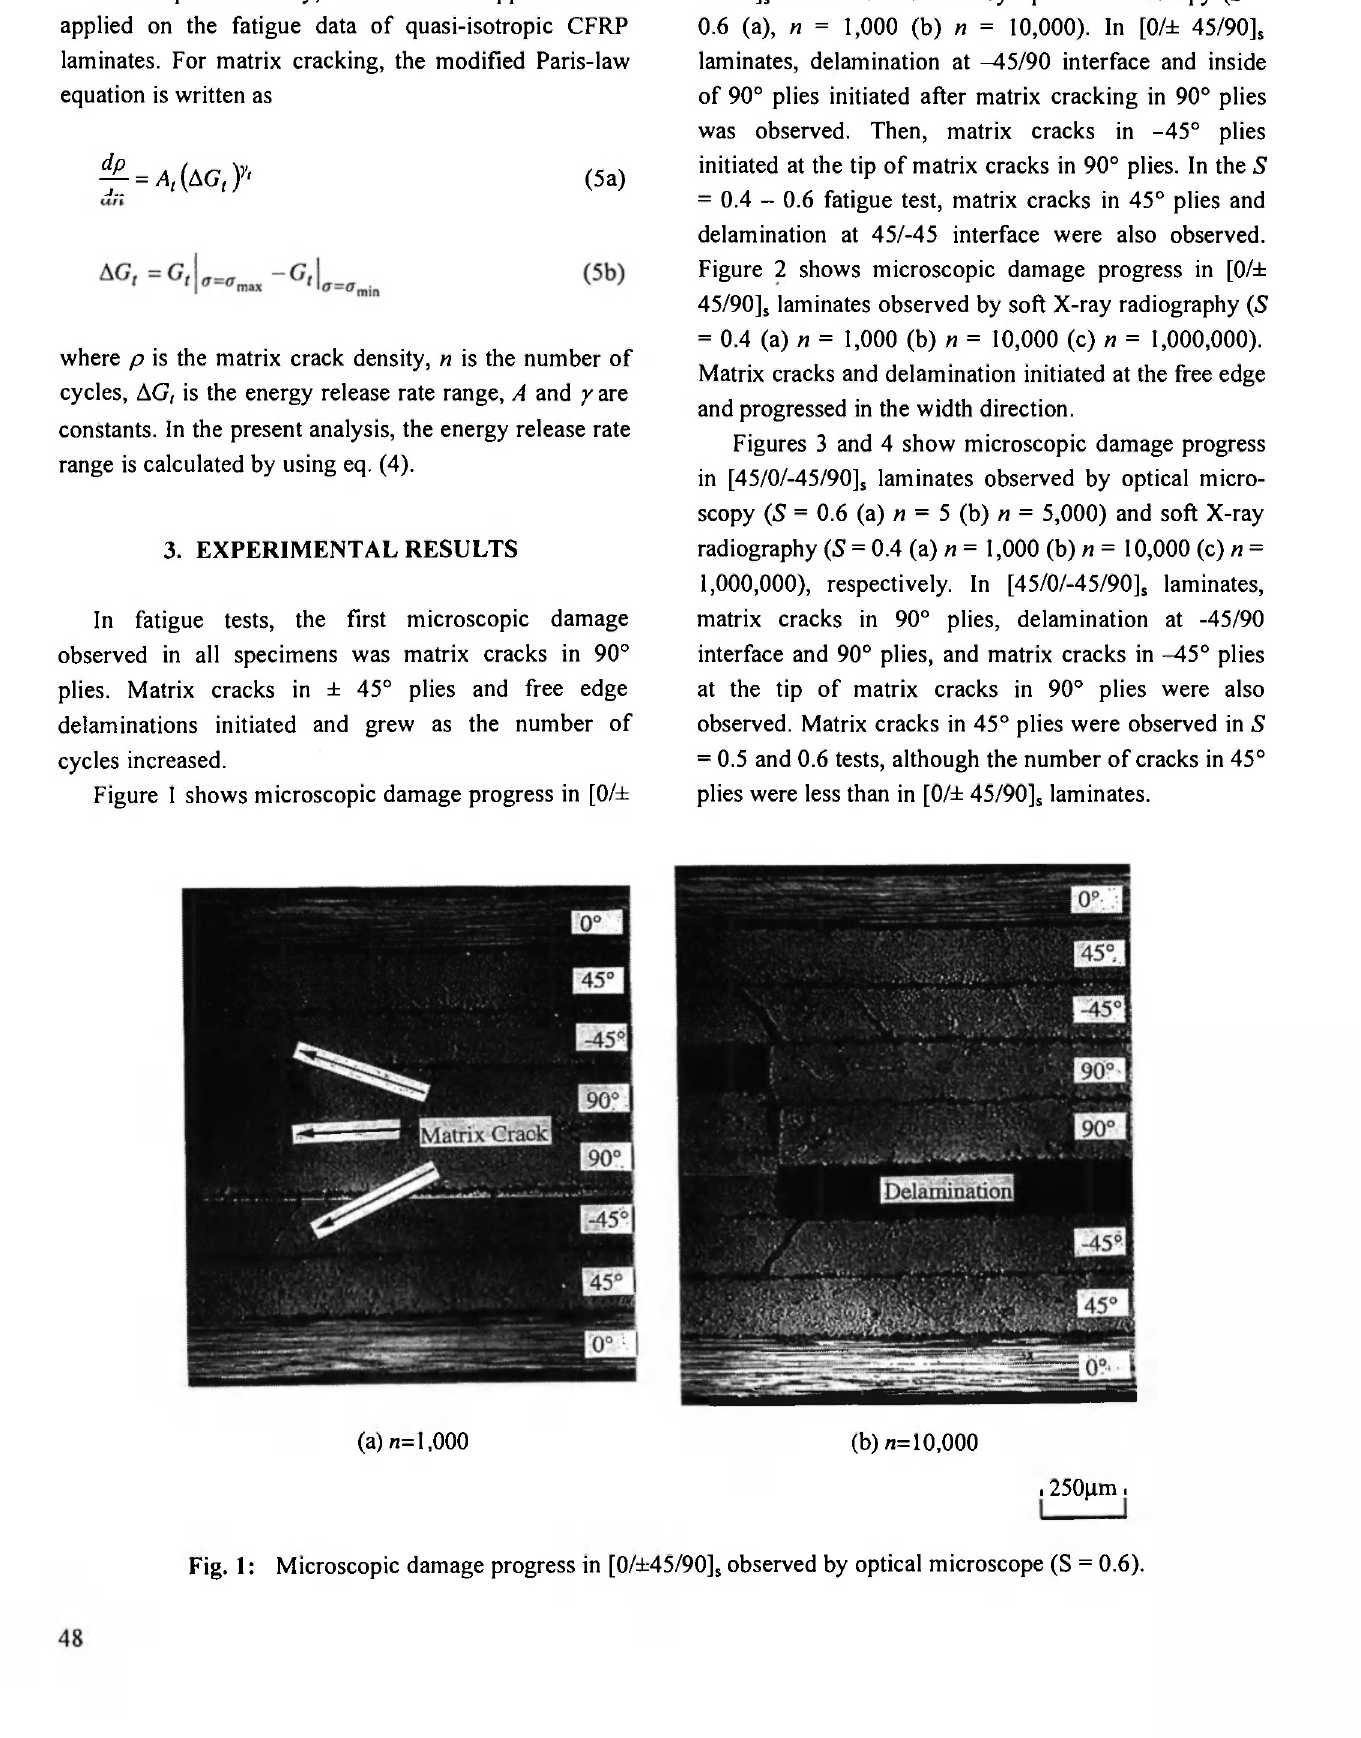
Fig. 1: Microscopic damage progress in [0/±45/90] s observed by optical microscope (S =